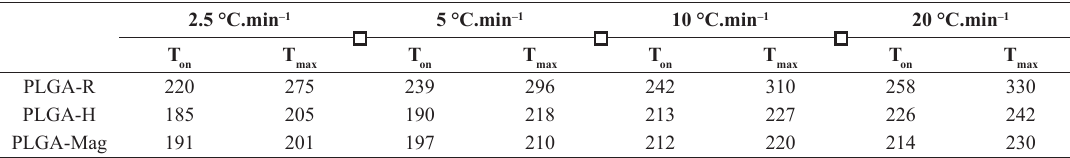
and T for PLGA-R, PLGA-H and PLGA-Mag at the four heating rates used on Vyazovkin method (T on max